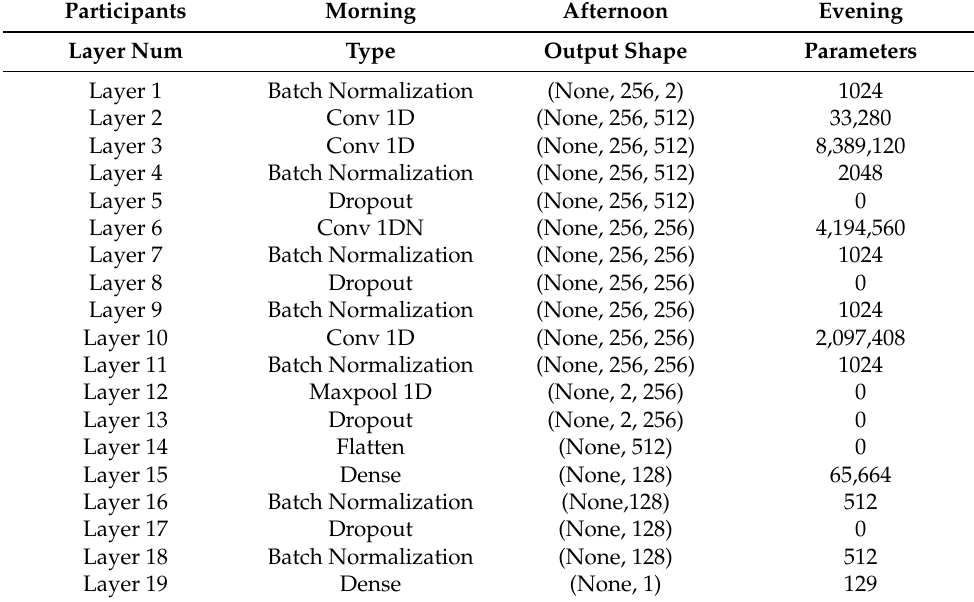
Table 6. Summary of our